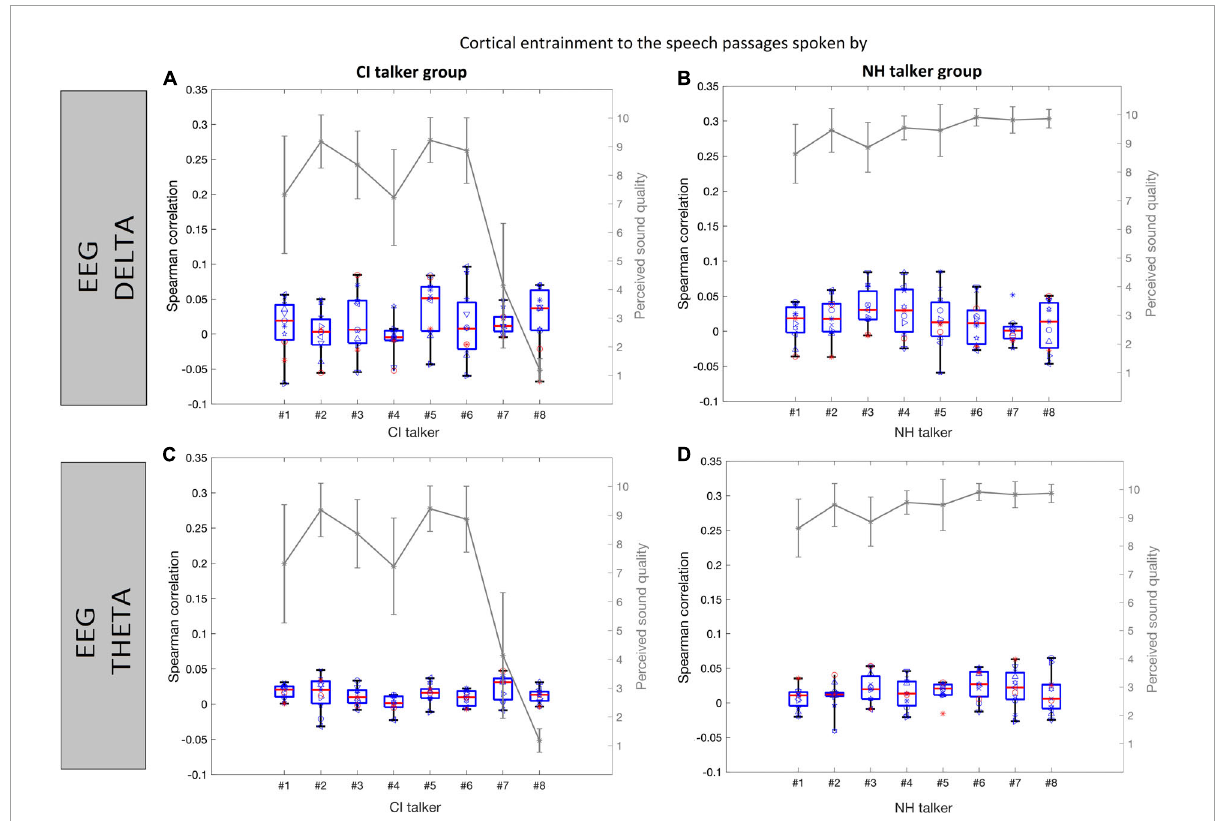
FIGURE7 Cortical entrainment to speech envelope ( < 40 Hz) in the normal-hearing listeners is shown for each of the speech passages from the CI talker group (A,C) and NH talker group (B,D) using EEG in delta and EEG in theta bands, respectively. The data are represented in the form of the boxplots depicting medians (center mark) and interquartile ranges (the bottom and top edges of the box indicate the 25th and 75th percentiles). The boxplot shows the entrainment data variance across listeners, and the individual listener’s data points are plotted over it. Each listener is shown with a different symbol. The perceived sound quality curve (gray) is also shown for